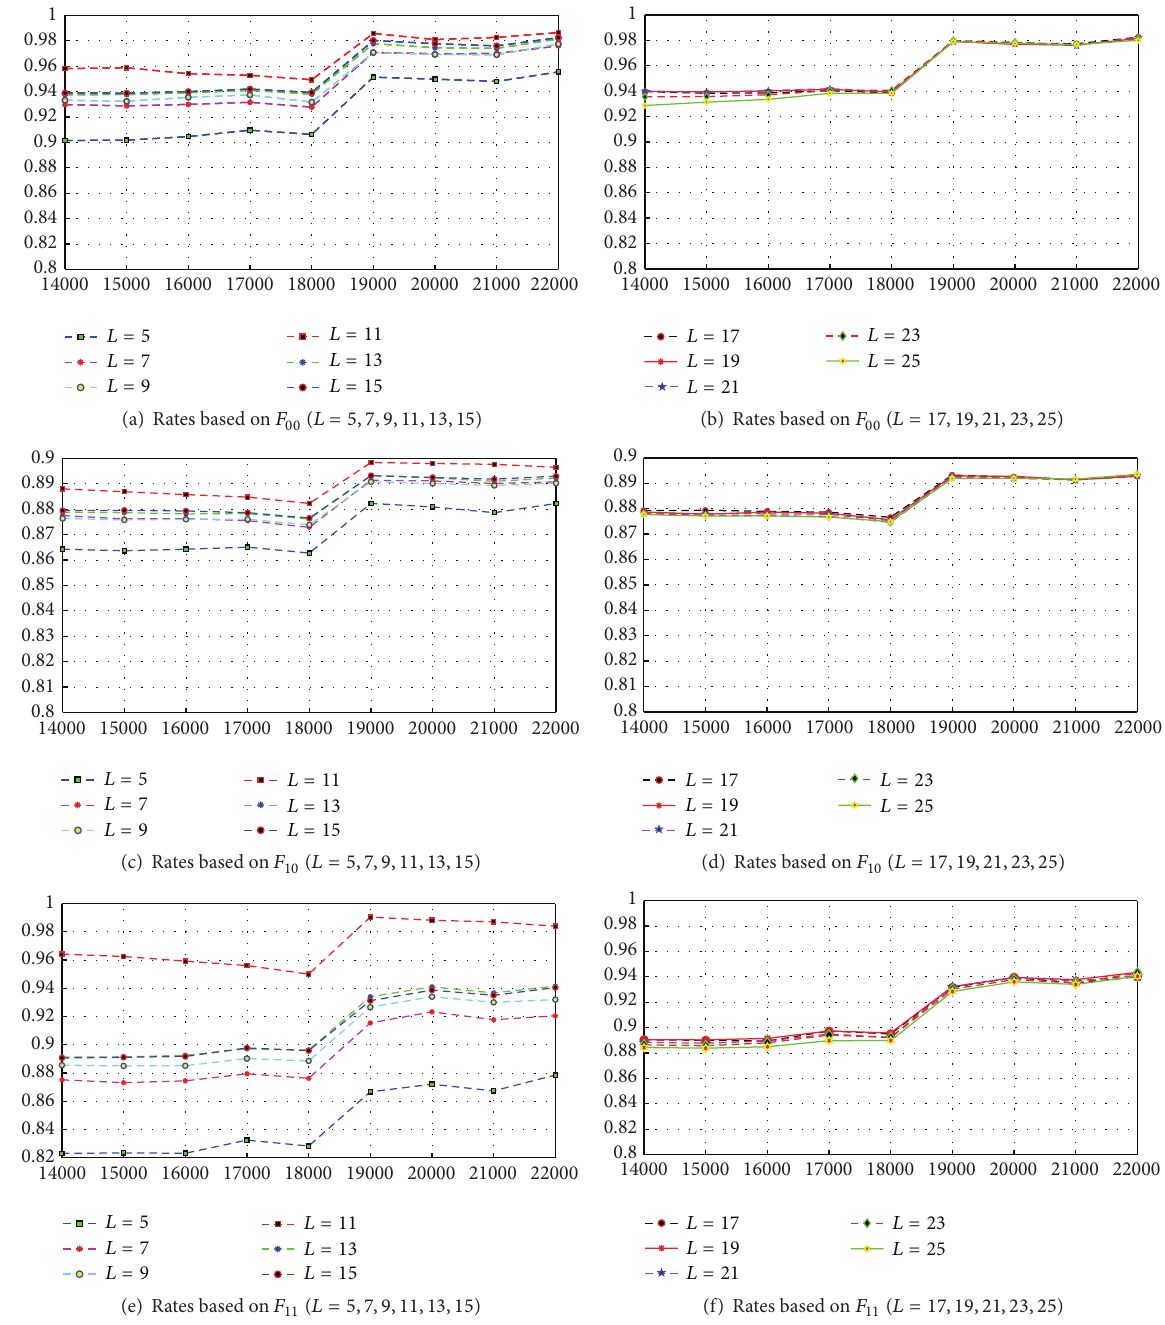
Figure 1: Classification accuracy rates based on deferent features with deferent sample